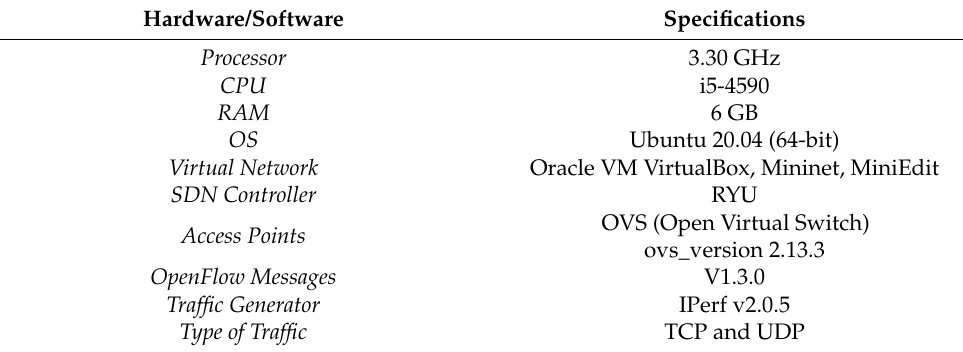
Table 3. Experimental Environment.